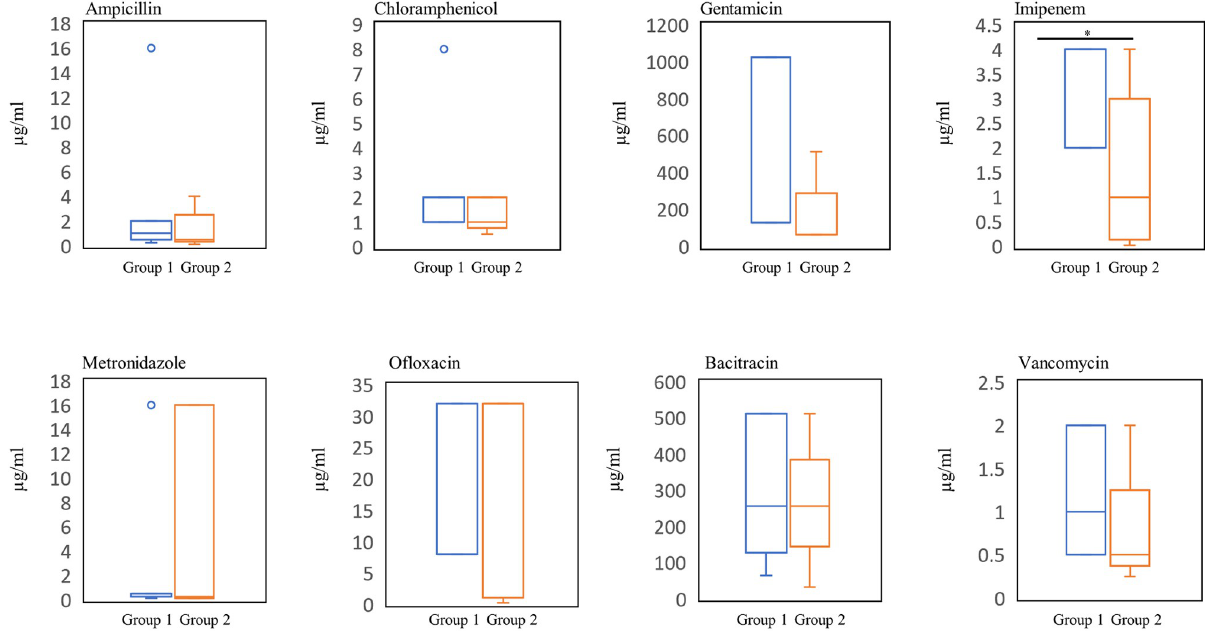
Fig 4. Comparison of susceptibility of Groups 1 and Group 2 to antibacterial agents. The distribution of MICs is shown. Student’s t test was used to determine significant differences between the Group 1 and Group 2 C . difficile strains.